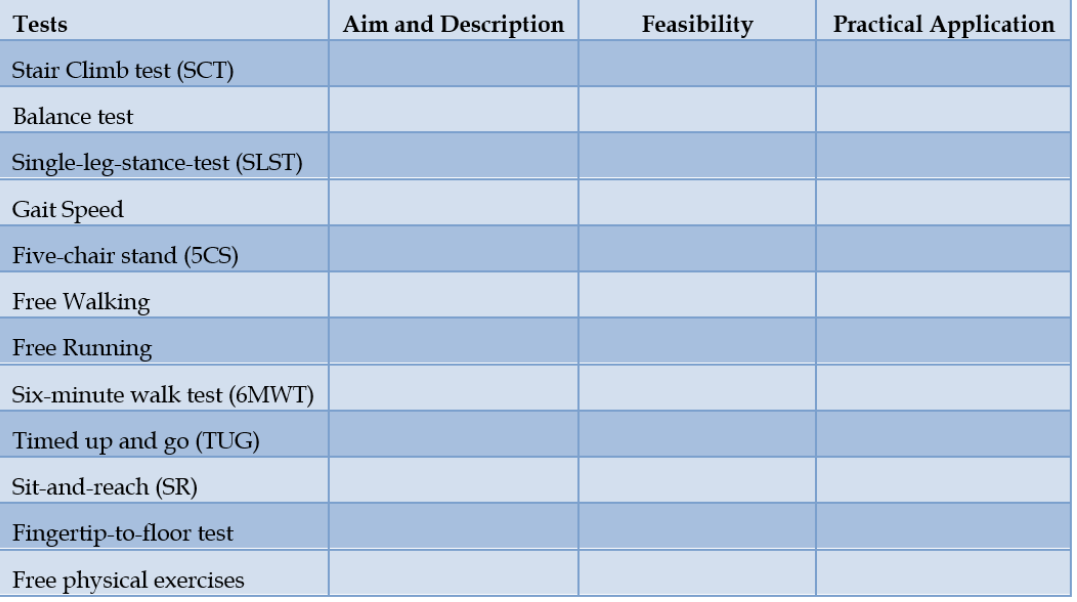
Figure 2. Spreadsheet suggestion to allow the individual to register the aims, feasibility and practical application to guide the home-based exercises adapted from the physical tests.